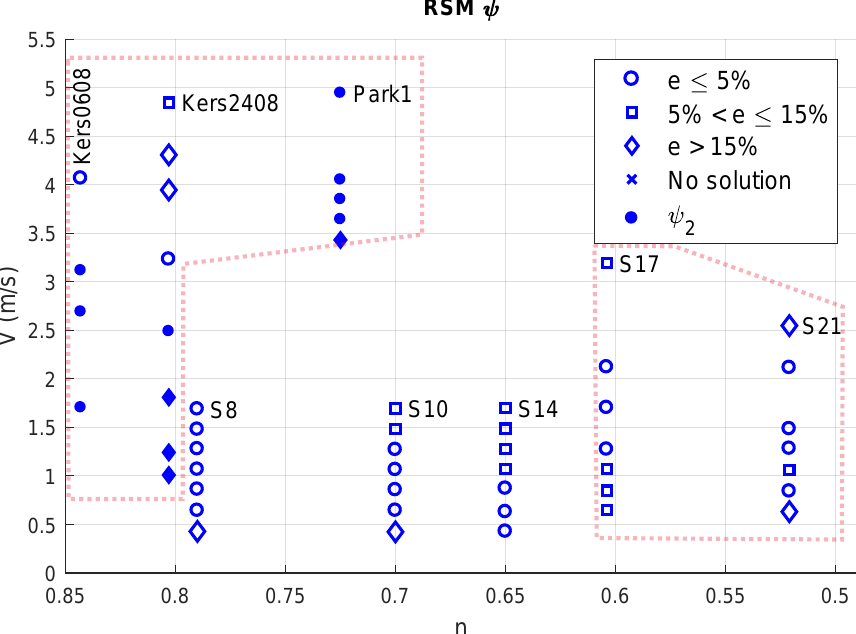
Figure 8. Error with the RSM with ψ 1 (or ψ 2 , filled